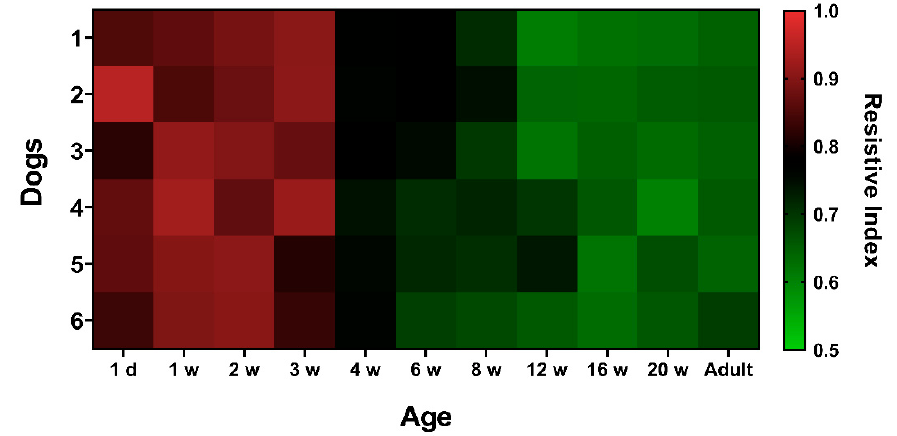
Figure 2. Heat map showing the renal resistive index value for each dog over the different ages of the puppies and the adult dogs. Red shows the high values and green the low values of the resistive index.